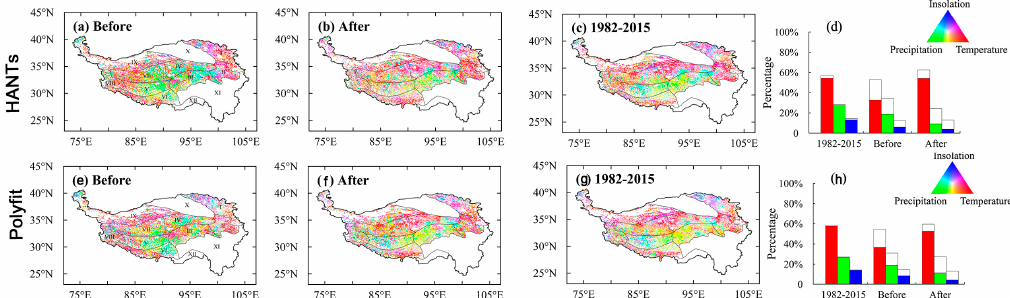
Remote Sens. 2021 , 13 , x FOR PEER REVIEW 14 of 16 Figure A2. Relative proportions of the three climate variables that contributed to the EOS in each subregion. The legend coloring is same as in Figure 5. The white portions indicate that the proportion is not significant ( p > 0.05).